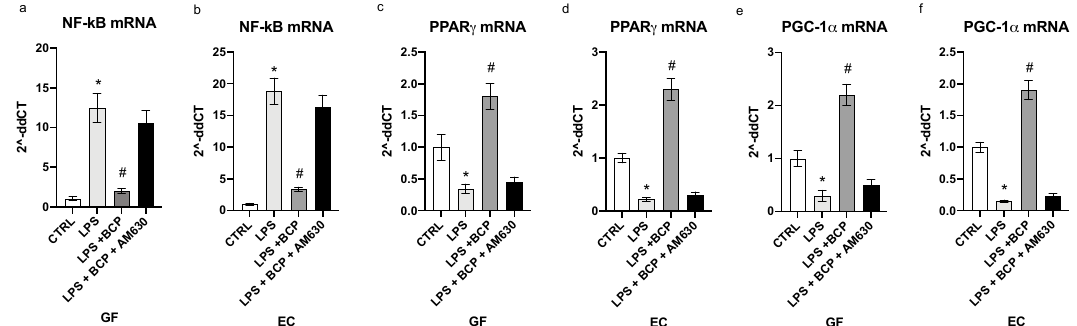
Figure 3. The graphs represent the qPCR results of NF-kB ( a ), PPAR γ ( c ), PGC1 α ( e ) mRNA expression from GF cells and NF-kB ( b ), PPAR γ ( d ), PGC1 α ( f ) mRNA expression from EC cells. Values are expressed as the means and SD. * p < 0.0001 vs. CTRL; # p < 0.0001 vs. LPS.